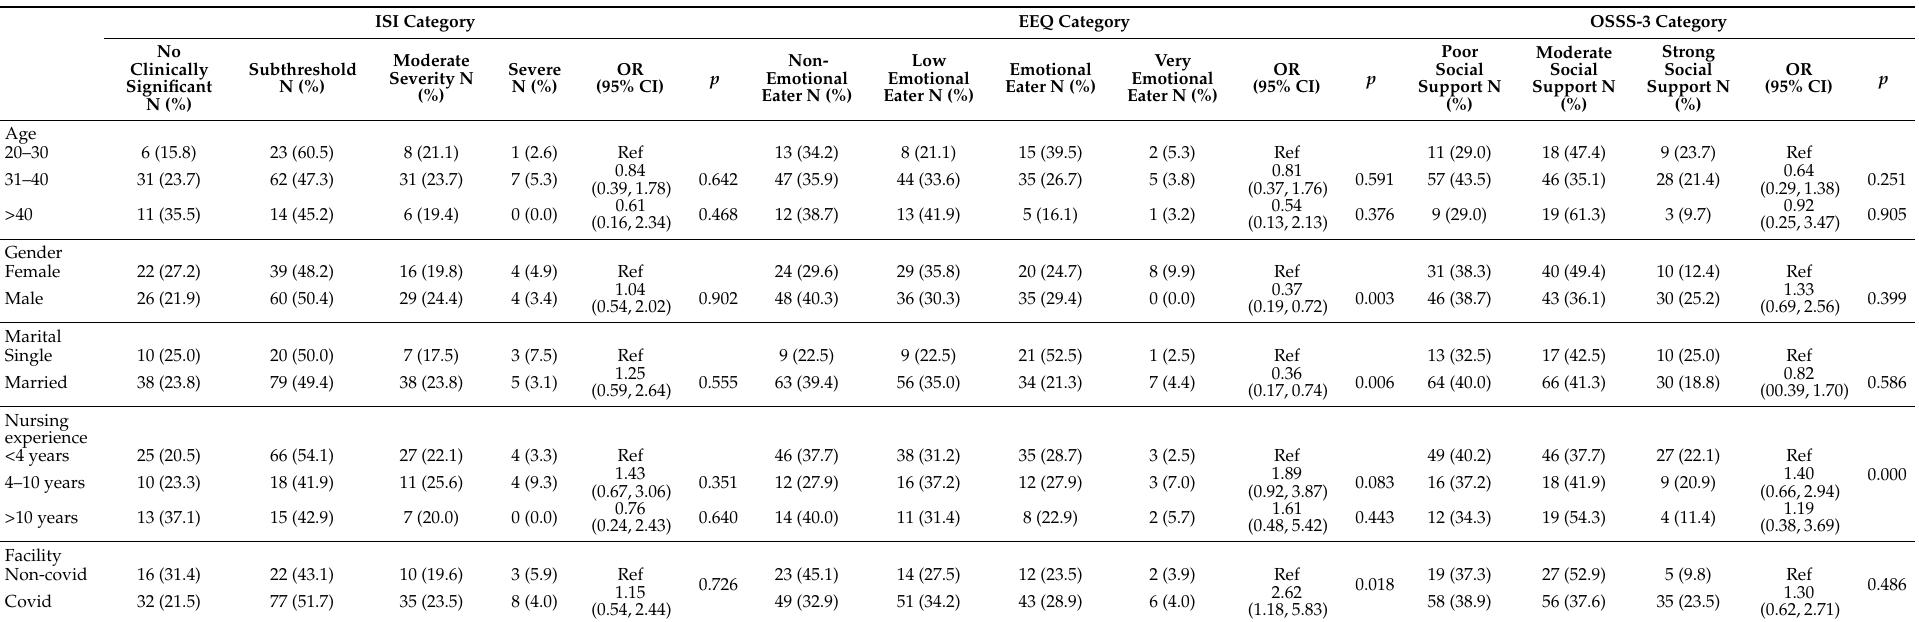
Table 2. Adjusted associations between characteristics of nurses and ISI, EEQ, and OSSS-3